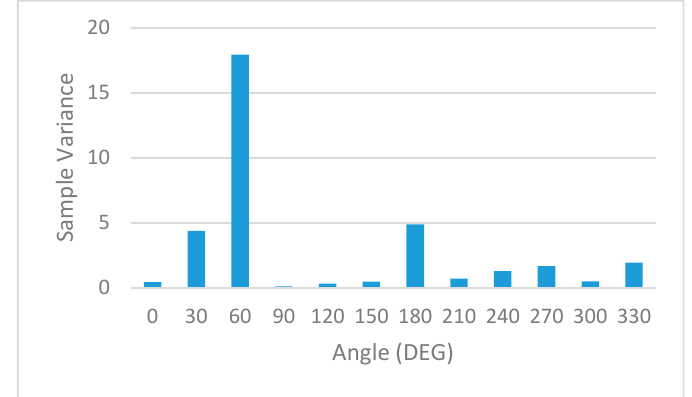
Figure 24. Statistical analysis. Sample variance of RSSI measurements.